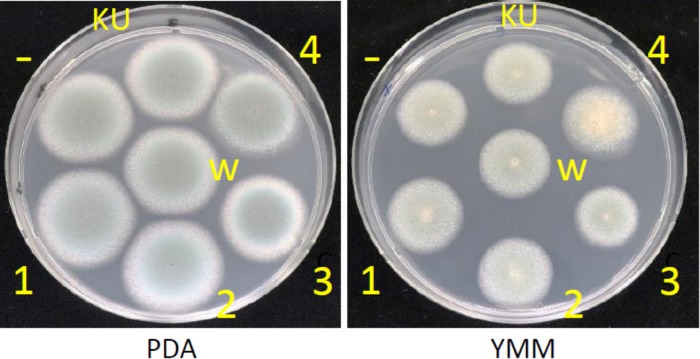
Colony morphologies of the whole-virus infected KU strain, AfuCV41362 ORF-expressing KU strains and the native virus-free strain. 37°C, 24 h. KU, the virus-free KU strain. w, the whole-virus infected KU strain, 1–4, KU strains with forced expression of ORFs (introduced by transformation). -, KU strain carrying an empty vector.